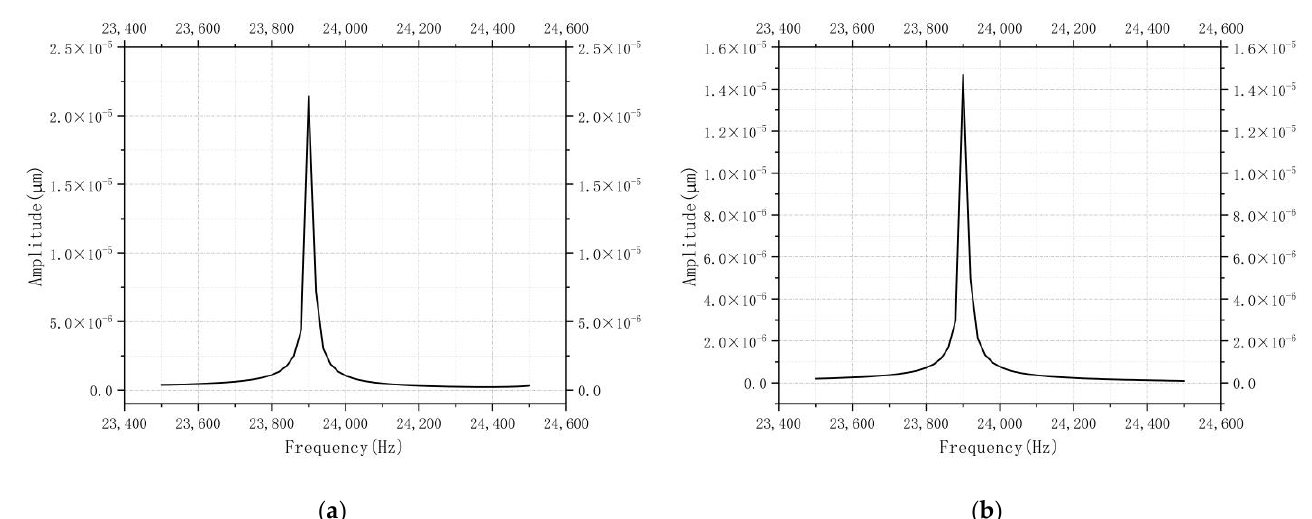
Figure 7. Frequency – amplitude curves: ( a ) X-direction harmonic response analysis; ( b ) Z-direction harmonic response analysis.